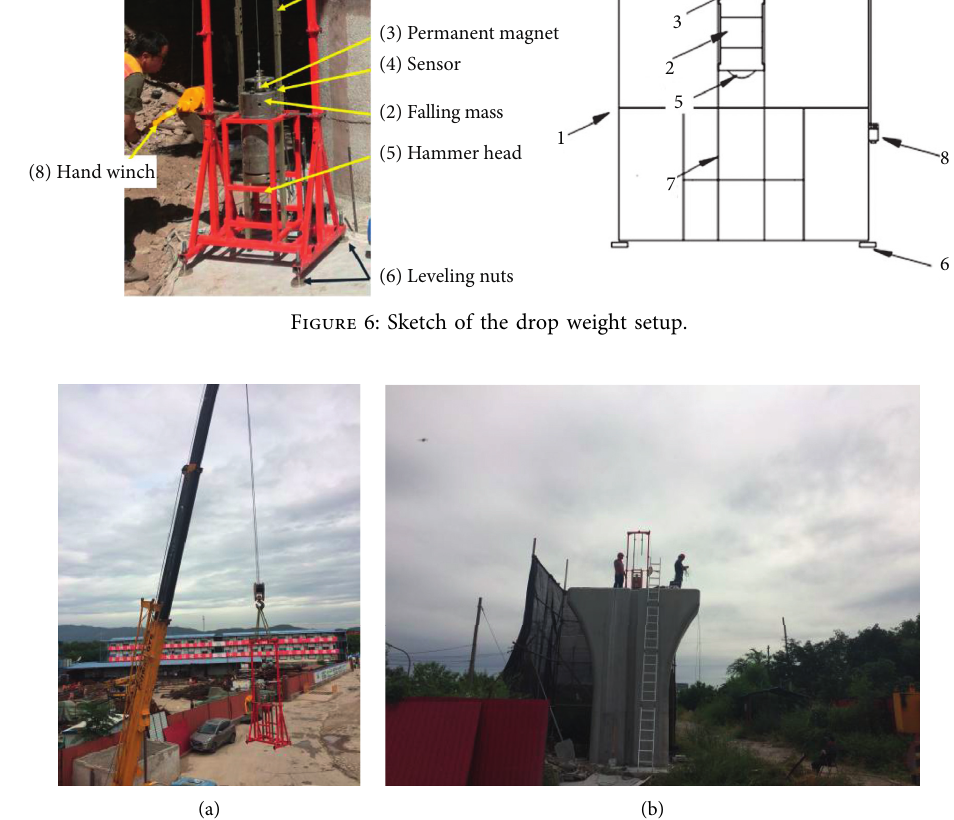
Figure 7: The drop weight setup was (a) lifted by crane and (b) onto the pier top.